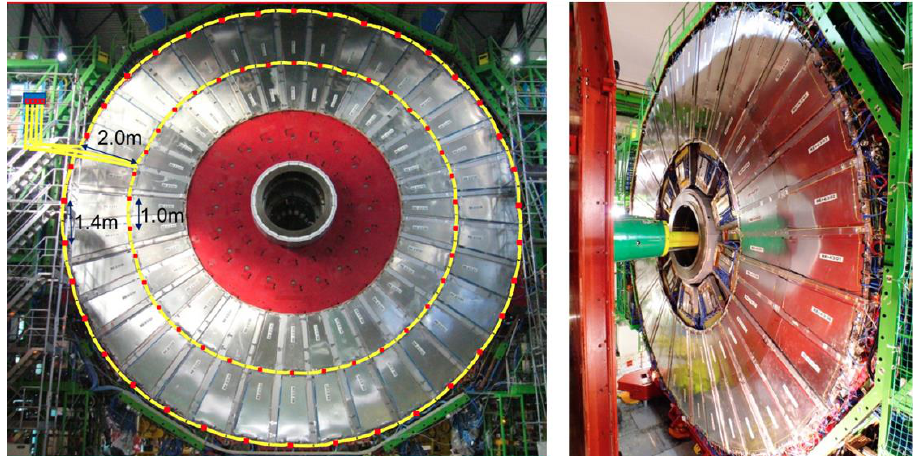
Figure 26. Layout of one of the six FBG temperature monitoring systems installed on the RPC endcap disks ( left ) and photo of the YE + 4 RPC disk with the FBGs array installed ( right ). Tracker RH Monitoring